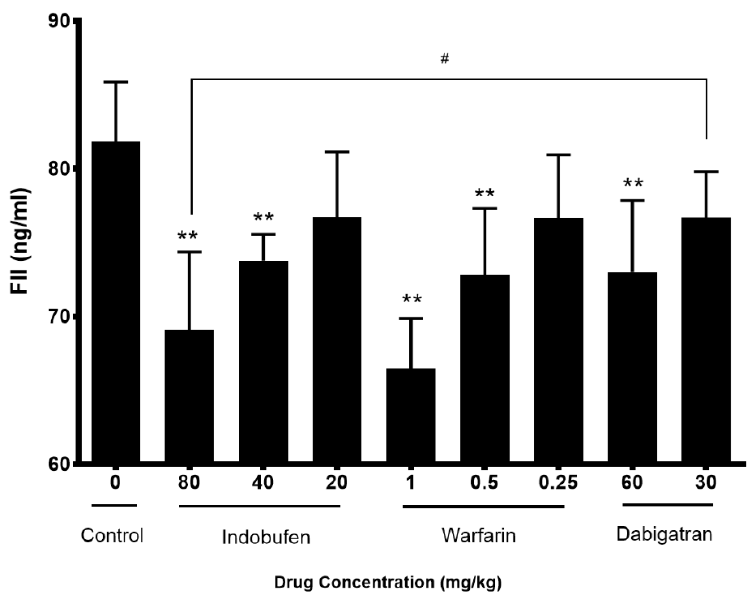
Figure 6. The effects of indobufen on the content of coagulation factor 2 (FII) in rats. ** p < 0.01 versus the control group; # p < 0.05, versus the dabigatran 30 mg/kg group (mean ± S.D., n = 10).